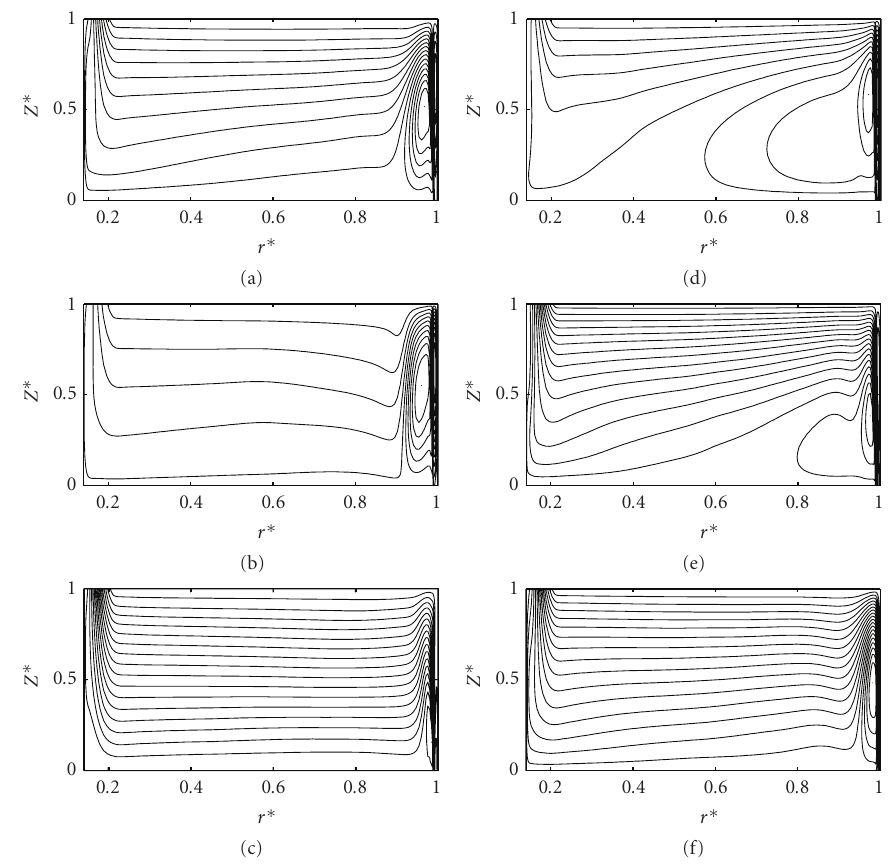
Figure 24: 20 streamline patterns Ψ ∗ for G = 0 . 02 and six sets of parameters (Re, C w ): (a) (1 . 8 × 10 5 , 2500), − 398 . 68 ≤ Ψ ∗ ≤ 151 . 17; (b) (1 . 8 × 10 5 , 5000), − 714 . 6 ≤ Ψ ∗ ≤ 115 . 9; (c) (1 . 8 × 10 5 , 10000), − 1274 . 1 ≤ Ψ ∗ ≤ 82 . 89; (d) (10 6 , 2500), − 127 . 01 ≤ Ψ ∗ ≤ 37 . 5; (e) (10 6 , 5000), − 117 . 11 ≤ Ψ ∗ ≤ 23 . 18; (f) (10 6 , 10 000), − 201 . 77 ≤ Ψ ∗ ≤ 58 .